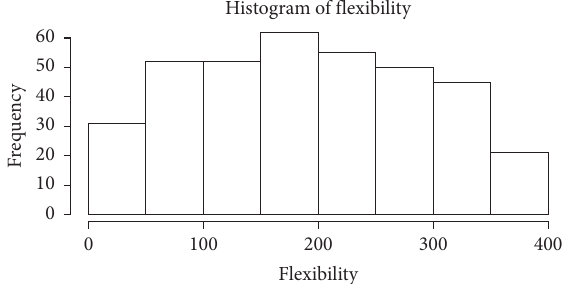
Figure 7: Distribution histogram of flexibility in 368 games.